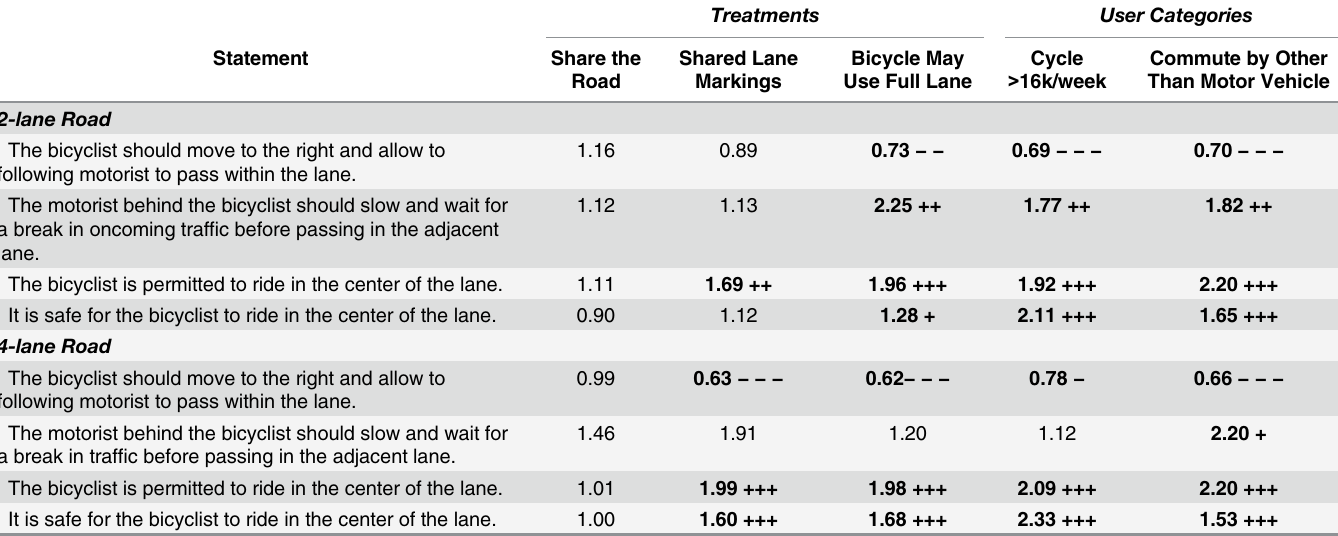
Table 2. Comparison of agreement with four road use statements by treatment and by two user categories on 2- and 4-lane